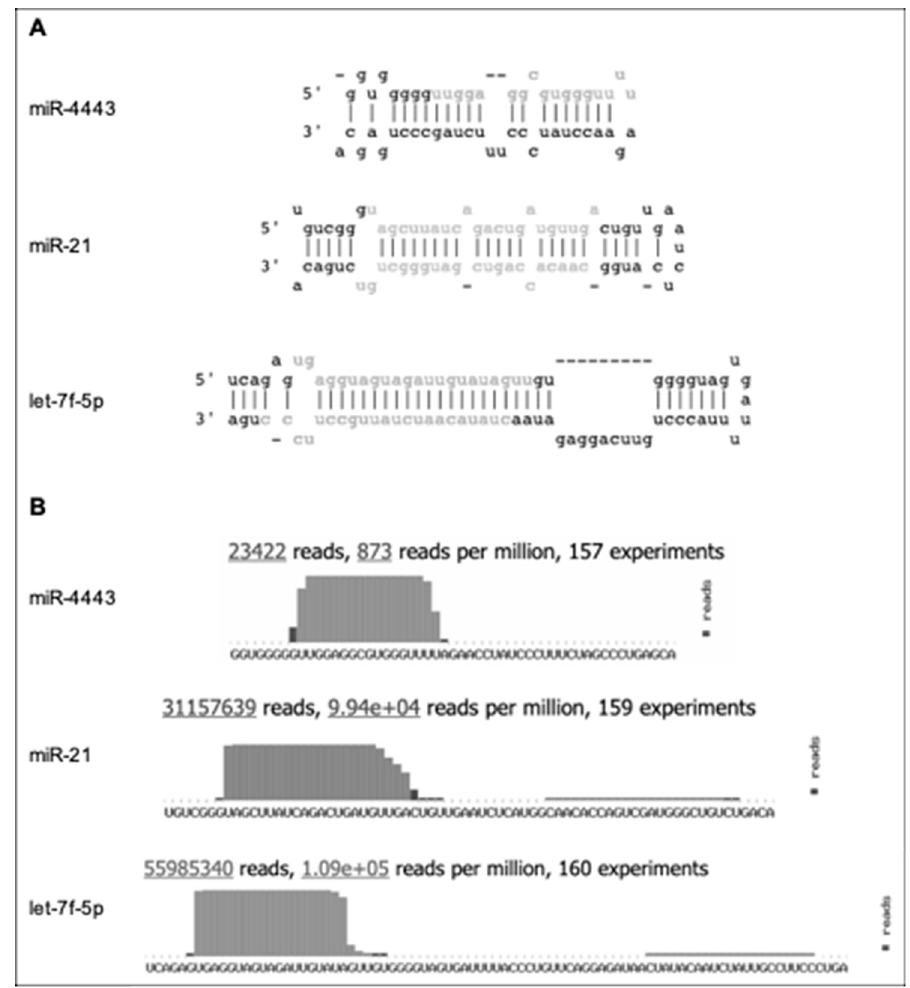
Figure 1. Indirect evidence for non-canonical biogenesis of miR-4443. Adapted from miRbase (http://www.mirbase.org/cgi-bin/mirna_entry.pl?acc=MI0016786), with let-7f-5p and miR-21 included for comparison. ( A ) The predicted stem-loop structure of pre-miR-4443 compared with the structures of pre-let-7f-5p and pre-miR-21. Mature microRNA sequences are shown in gray. ( B ) The deep sequencing evidence for mature miR-4443, compared with let-7f-5p and miR-21. Note the short (17 nt) mature sequence, short terminal loop, and lack of evidence for passenger strand for miR-4443.